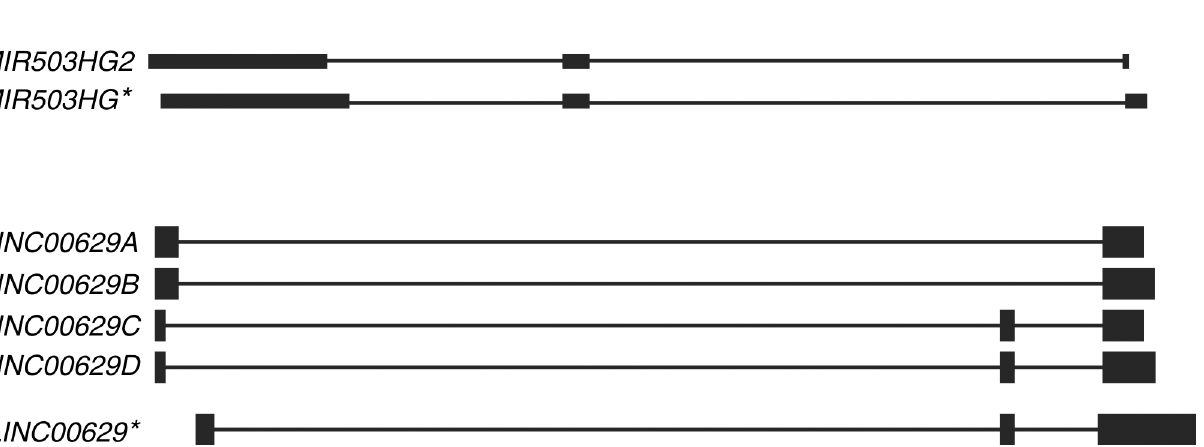
Fig 6. New isoforms of MIR503HG and LINC00629 genes were identified. A. MIR503HG new isoform, named MIR503HG 2. B. LINC00629 four new isoforms containing either two exons ( LINC00629A and LINC00629B ) or three exons ( LINC00629C and LINC00629D ). The sequences were aligned by BLAT tool to the human genome (http://genome.ucsc.edu. version : Feb . 2009 , CRCh37/hg19) . * Reference isoforms.